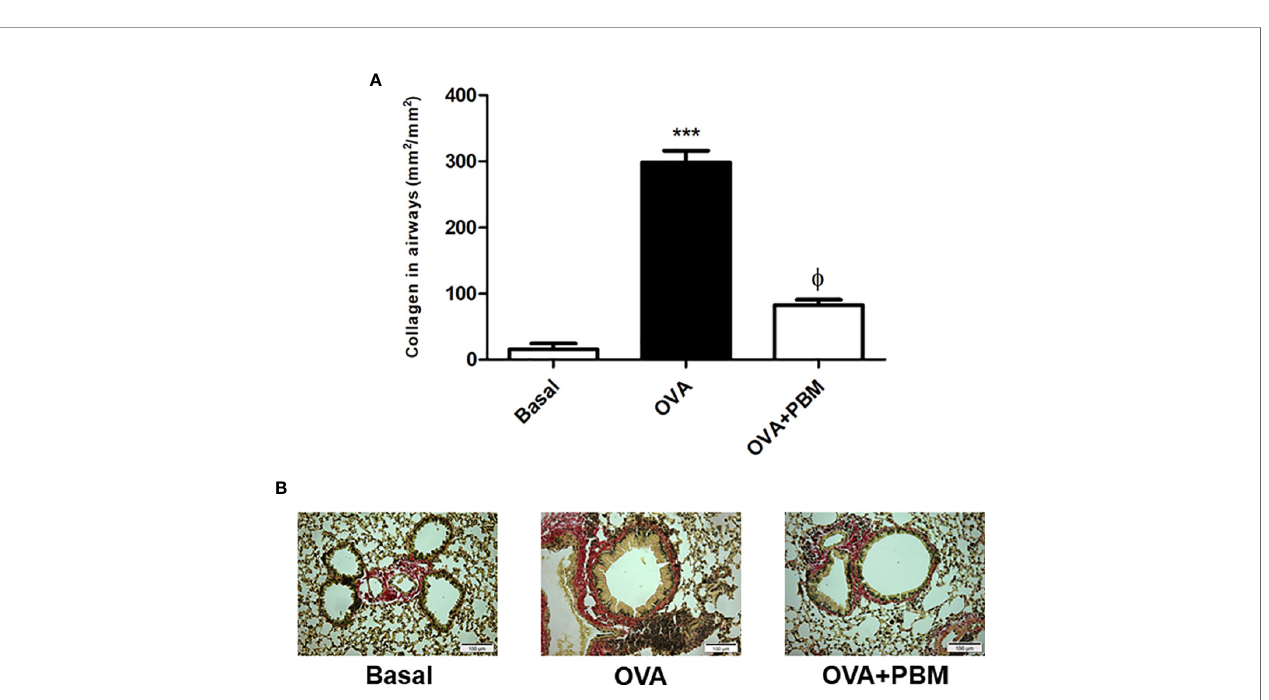
FIGURE 5 | Effect of photobiomodulation on airway collagen deposition. Quanti fi cation of collagen fi ber deposition in the airways (A) The photomicrographs represent all the groups studied (B) . Basal group, n = 5; OVA group, n = 7; PBM, group n = 5; OVA+ PBM, n = 8. Two independent sets of experiments were carried out. Data represent mean ± standard error (EMP). ***p < 0.001 in relation to the Basal group. fp < 0.001 in relation to the OVA group. f p < 0.001 in relation to the OVA